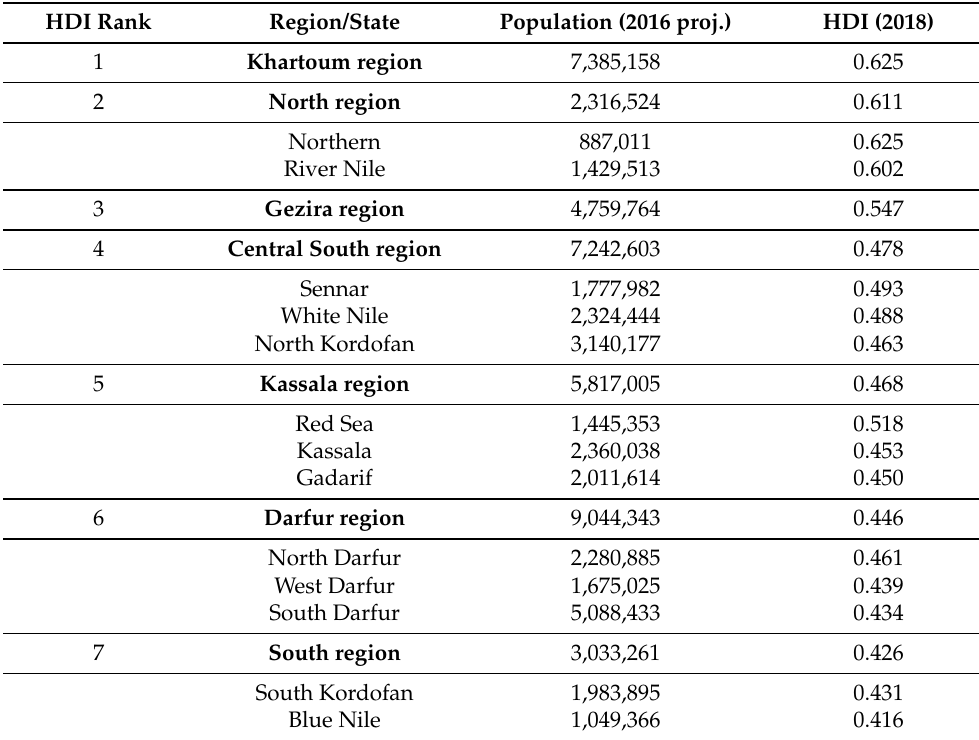
Table 1. Population and human development index (HDI) for different regions and states in Sudan CBS (2018); Global_Data_Lab (2019). Regional HDI values are obtained from states’ values, weighted by population. HDI